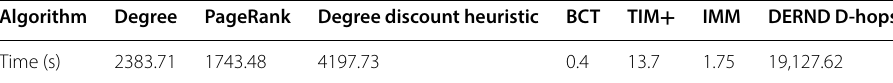
50 under the IC model =